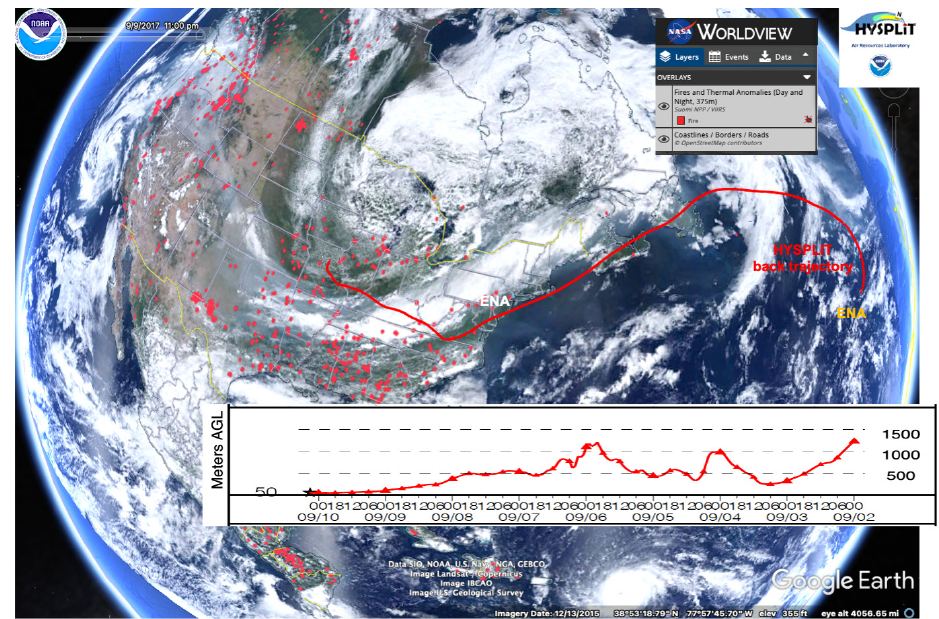
Figure 6. NASA Worldview VIIRS 375, active fires between 1 and 15 September 2017 (red circles) and HYSPLIT back trajectories arriving at 50ma.g.l. above the ENA site on 10 September 2017 (© Google Earth